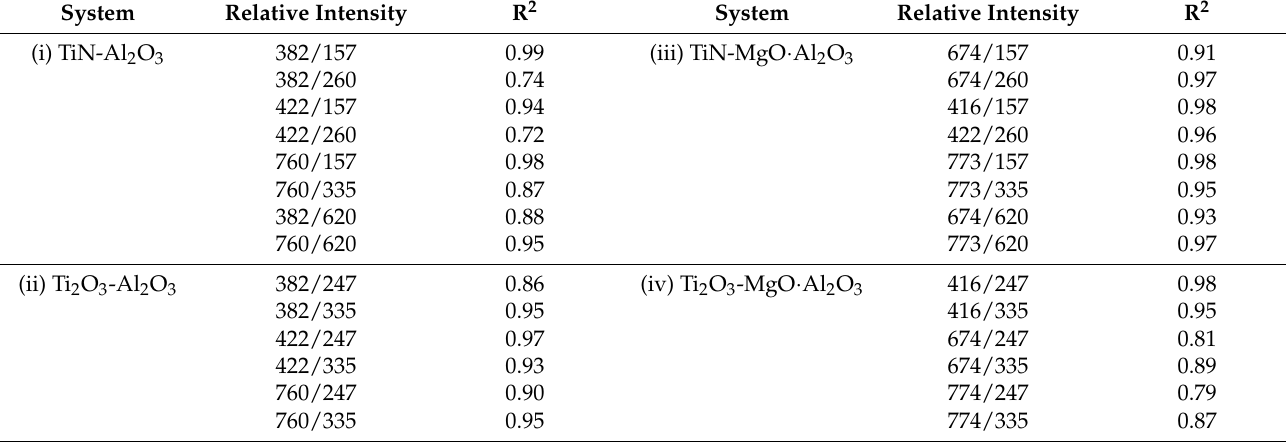
Table 4. Estimation of the coefficient of determination (R 2 ) between the relative Raman peak area and phase content from XRF analysis for (a) TiN-Al 2 O 3 , (b) Ti 2 O 3 -Al 2 O 3 , (c) TiN-MgO · Al 2 O 3 , and (d) Ti 2 O 3 -MgO · Al 2 O 3 .